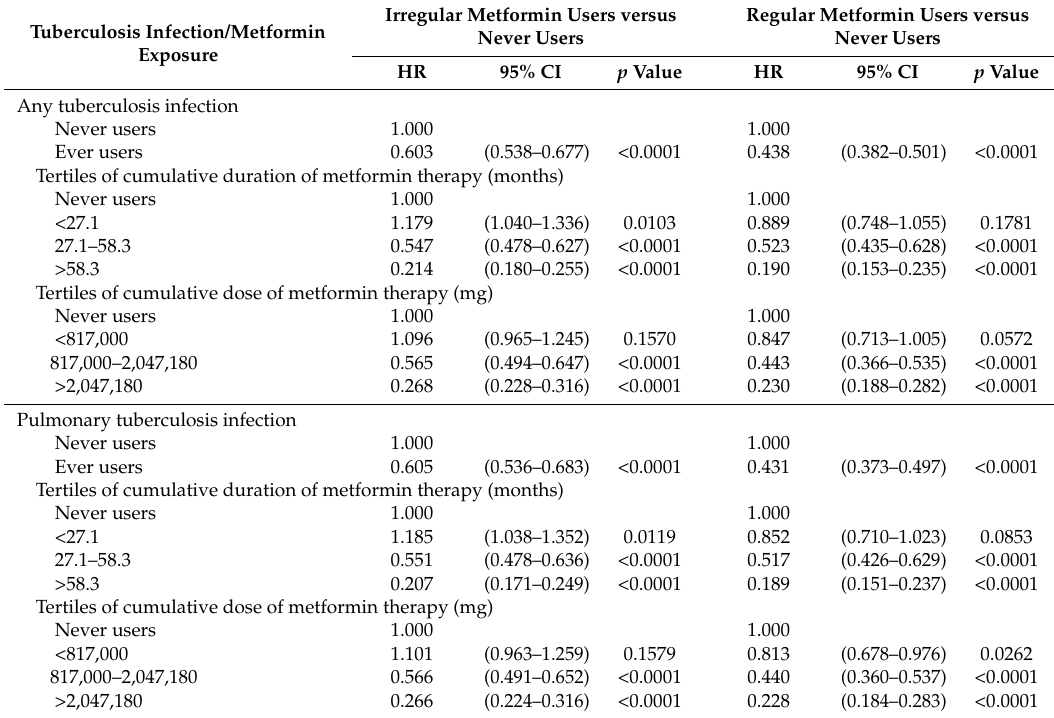
Table 4. Comparison of hazard ratios of tuberculosis infection between metformin irregular users and regular users versus never